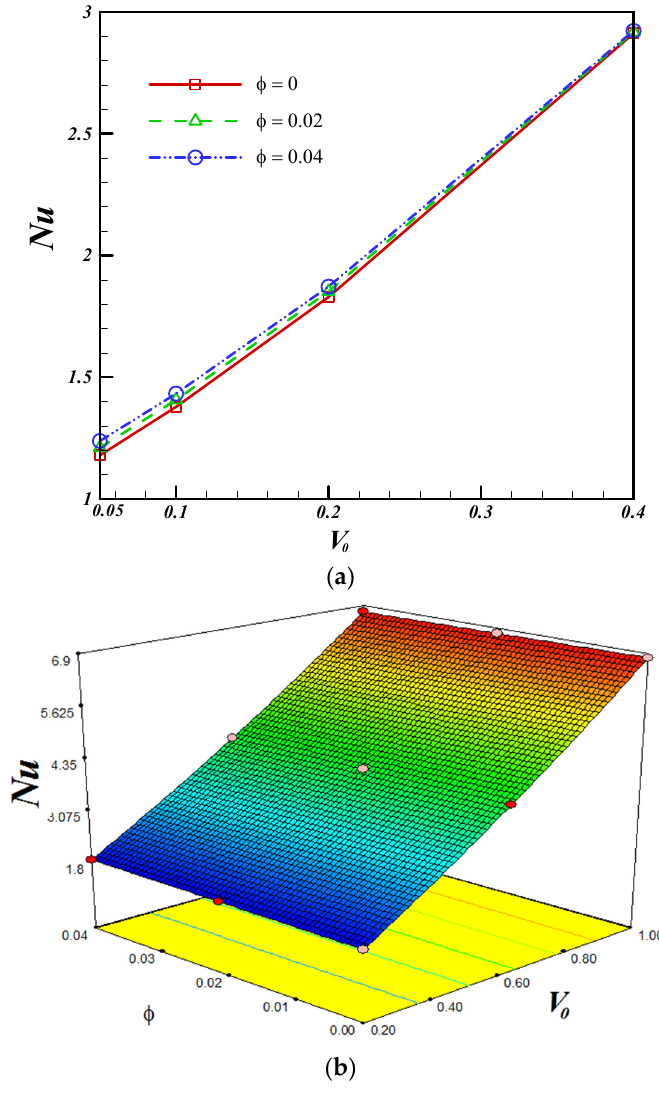
V ) on Nusselt number 0